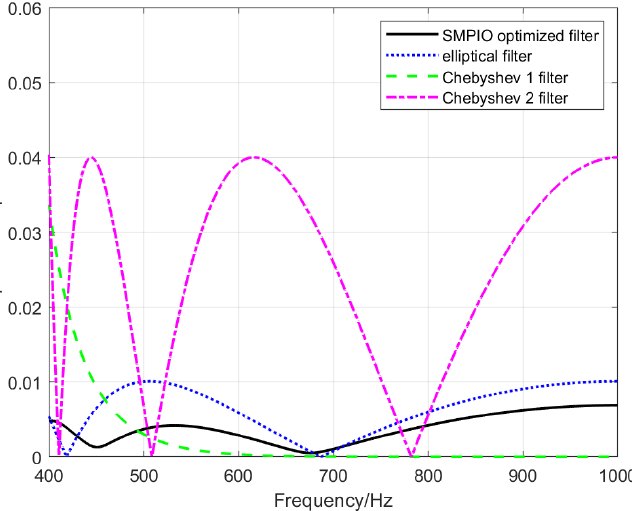
Figure 7. Amplitude response comparison of various types of filters (400 Hz~1000 Hz, m = 6, amplitude optimized).